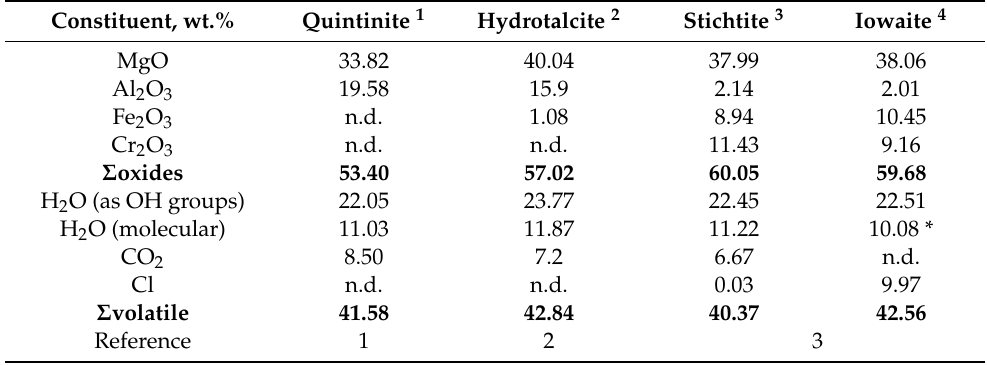
Table 2. Chemical composition of quintinite, hydrotalcite, stichtite, and iowaite obtained by electron-microprobe analyses of polished